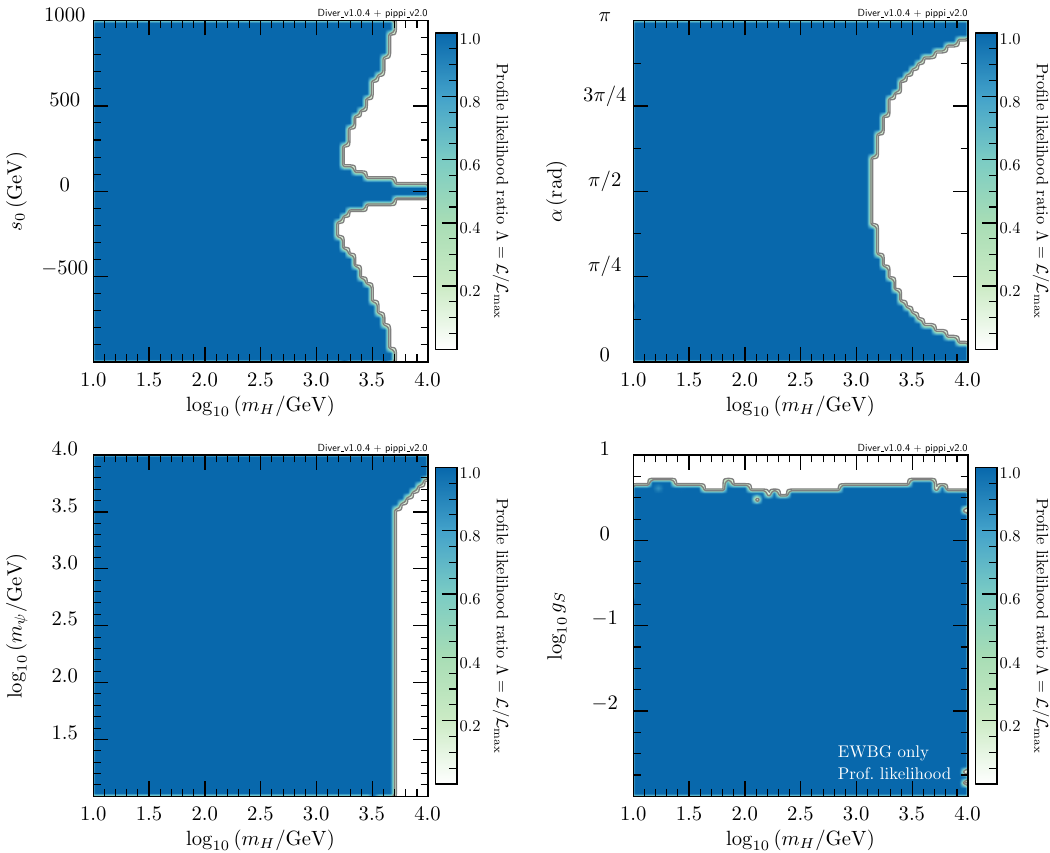
Figure 3 . 2D pro(cid:12)le likelihood (PL) plots from a 7D scan of our model using only the electroweak baryogenesis (EWBG) constraint. The contour lines mark out the 1 (cid:27) (68.3%) and 2 (cid:27) (95.4%) C.L. regions. In regions where (cid:3) = = 1, a successful EWBG can be viable as v c =T c (cid:17) L L max (see text for more details). The parameter planes ( m H ; (cid:22) 3 ) and ( m H ; (cid:21) S ) are not shown as they are unconstrained by the EWBG